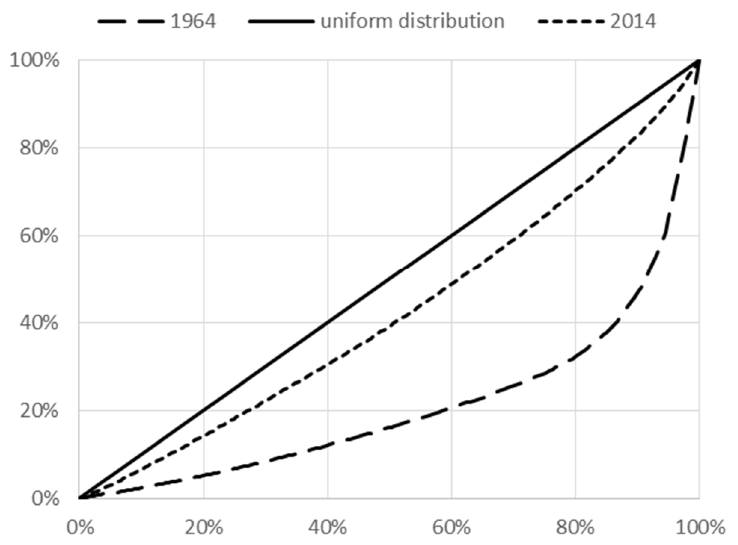
Figure 4. Lorenz curves for Zawichost hydrological station for the winter of 1964 and 2014. Ordinate (y) axis—cumulative share of days from lowest to largest daily flow. Abscissa (x) axis—cumulative share of daily flow in the sum of flow.